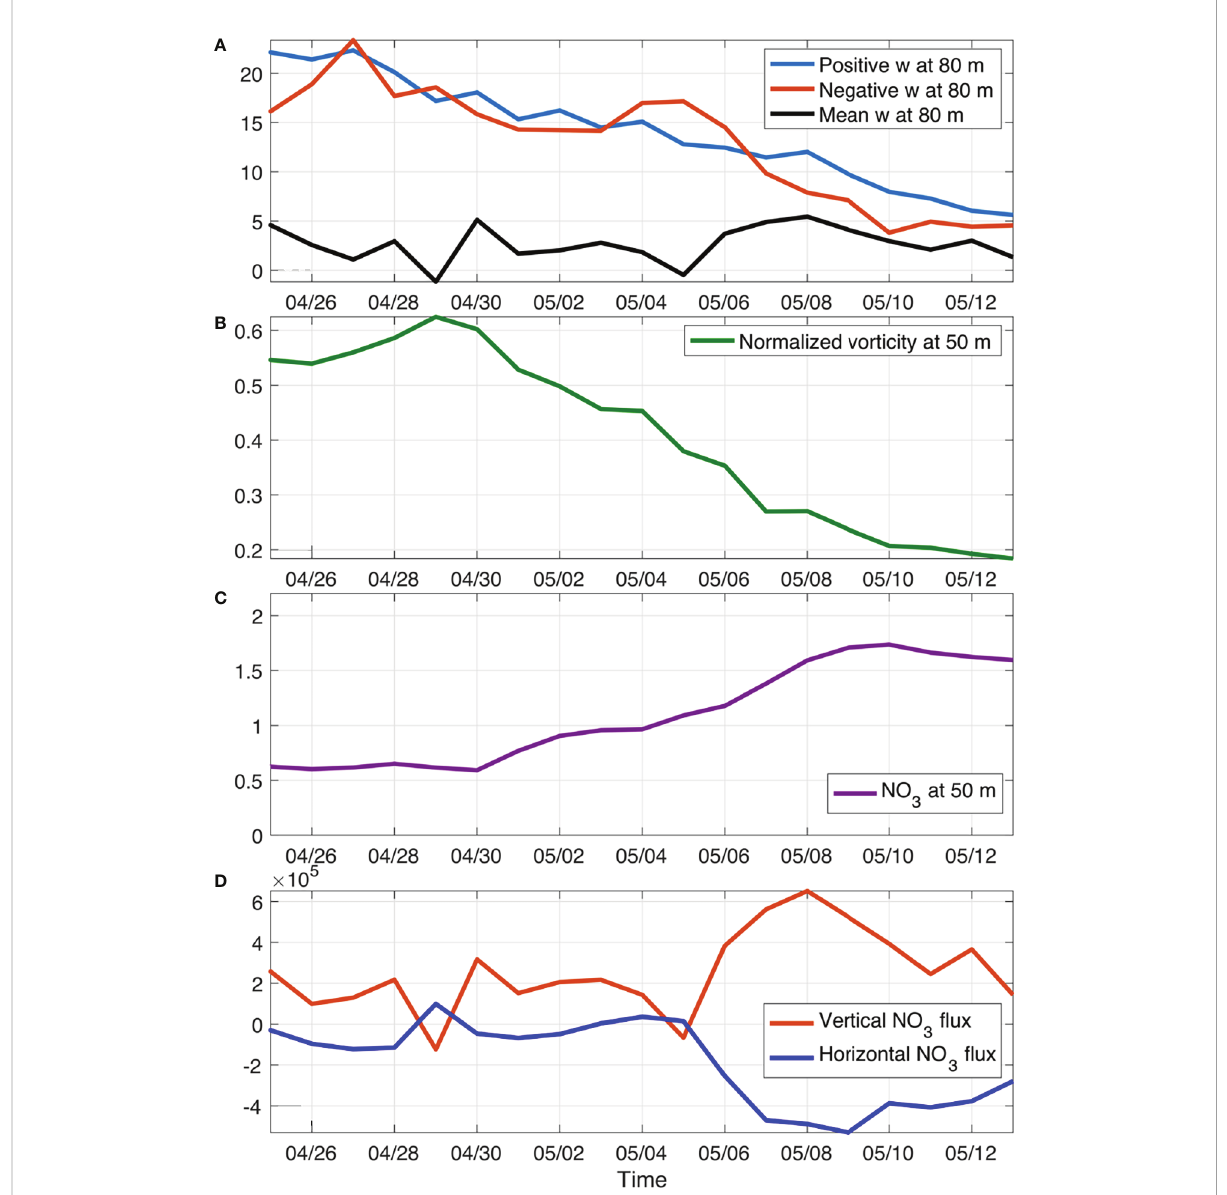
FIGURE 9 Temporal variations of box-averaged vertical velocities (A ; units: m d -1 ) , normalized vorticity by f (B) , nitrate concentration (C ; mmol m -3 ) , and nitrate fl uxes (D ; units: mmol s -1 ) following the movement of case1 patch. Here, the horizontal nitrate fl ux was calculated from surface to 80 m and the vertical fl ux was calculated at 80